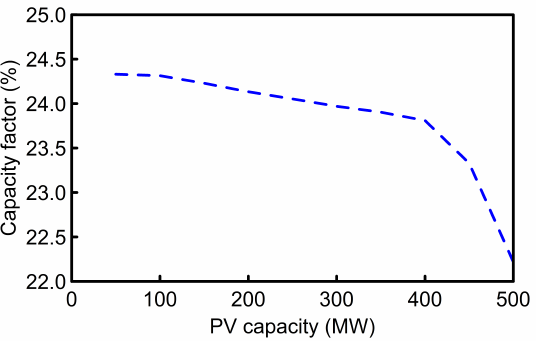
Figure 10. PV plant capacity factor based on penetration. Capacity factor can be observed to reduce with increase in curtailed power.